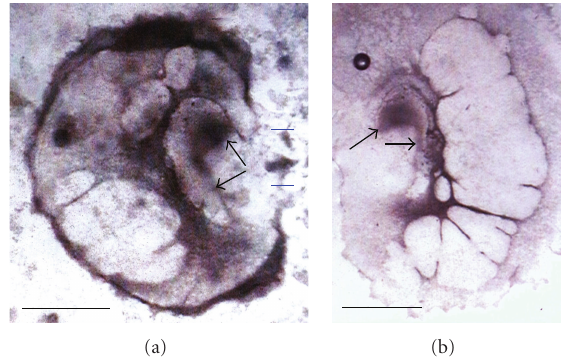
Figure 2: (a): Stereomicroscopic ventral view (alive) of the isolated right half of an unincubated chicken blastoderm after 1 day of culture; the hemi-embryo is localized close to the free cut edge (now bent). Two parts of the embryo are visible, the broad head region (upper arrow) and the trunk region with a narrow hemi- PS (indicated by lower arrow). Confirmed after sectioning and staining. (plane of sections, indicated by two parallel bars) Bar = 1mm. (b): Stereomicroscopic ventral view (alive) of the isolated left half of an unincubated chicken blastoderm after 1 day of culture. It forms a mirror image with the right half embryo of Figure 2(a) with the same indications. Bar = 2